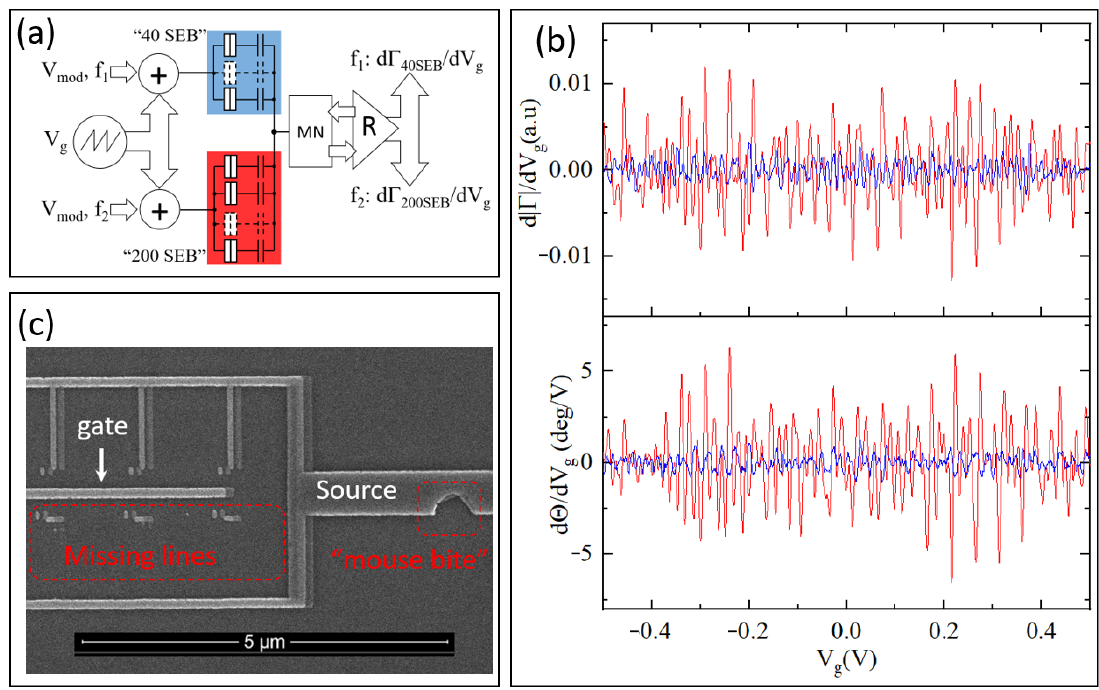
Figure 13. Comparison of the performance between two SEBA with a nominal number of SEB N = 40 (“40 SEB”, here and below marked blue) and N = 200 (“200 SEB”, here and below marked red) at T = 2.8 K. ( a ) Simplified block diagram of the experiment with 40 SEB and 200 SEB connected to the same resonator and sharing the same ramp voltage V g while modulated at two different frequencies, f 1 = 1.45 kHz for 40 SEB and f 2 = 2.48 kHz for 200 SEB. MN—matching network operating at 305.7 MHz; circles with “+” sign represent adders; R—reflectometer that includes ultra-high frequency lock-in amplifier by Zurich Instruments (ZI UHF) and SR830 lock-ins to extract derivatives by further demodulating the downconverted signals of the ZI lock-in. ( b ) Comparison of oscillation patterns for derivatives d| Γ |/dV g and d Θ /dV g representing magnitude and phase sensitivity for 40 SEB (blue) and 200 SEB (red) ( c ) Typical fabrication defects found in the devices inspected under SEM. The number of devices in the micrograph by design is 6, but the entire set of bottom source lines to individual SEB is missing.